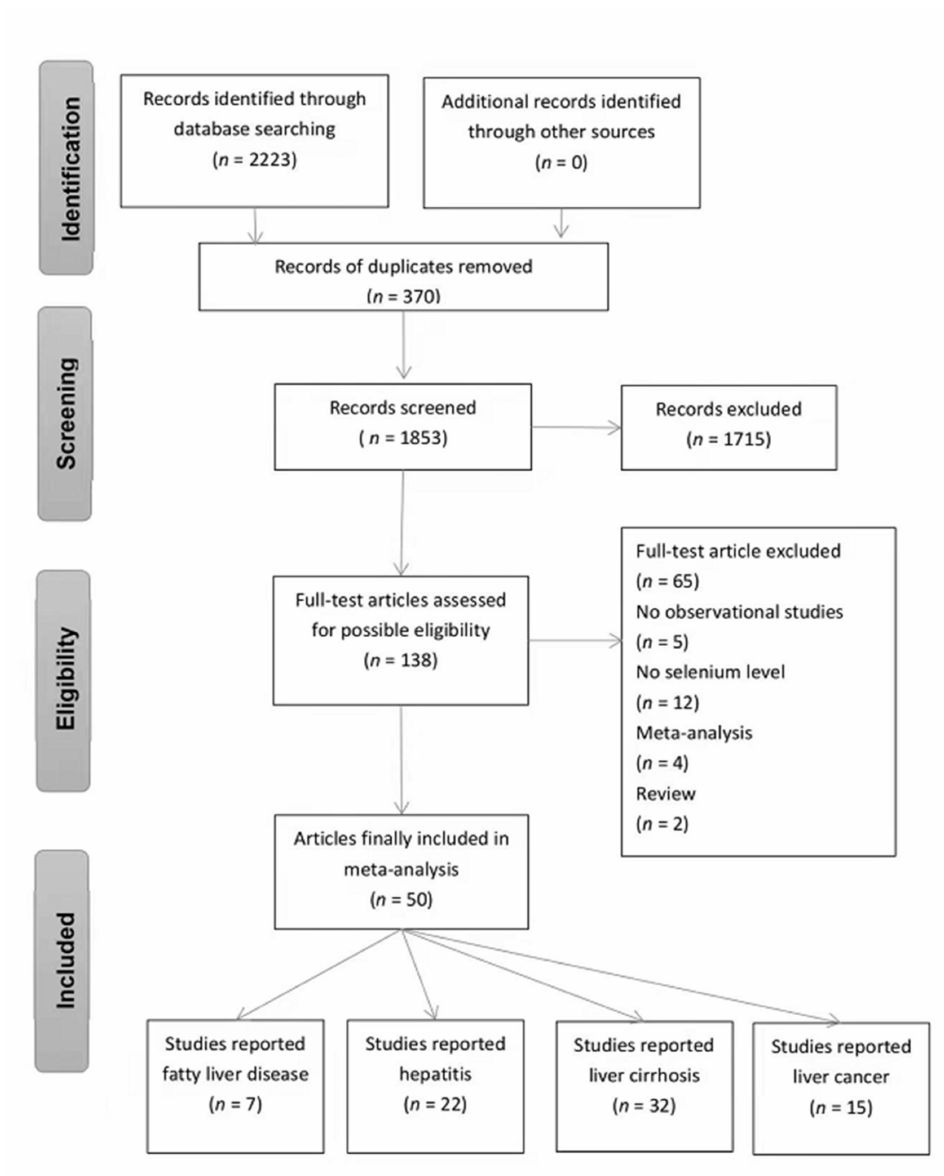
Figure 1. PRISMA diagram of primary studies. Table 1. SMD by study design, region, sample sources, year of publication, and blood selenium